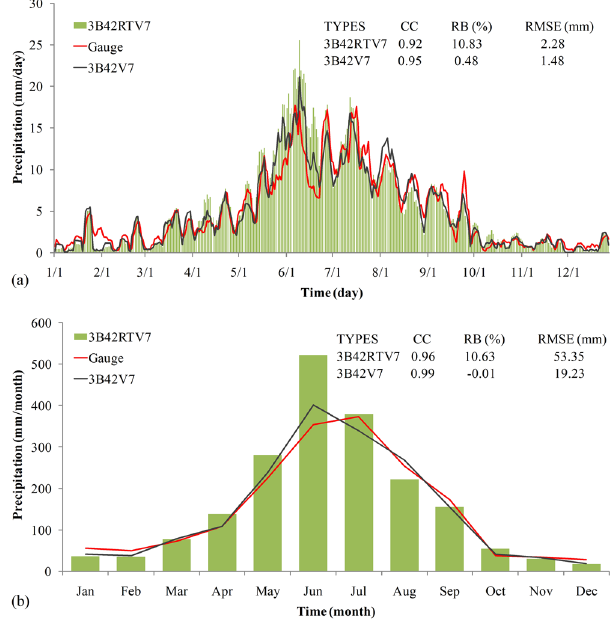
Figure 7. Selected grid-based mean daily ( a ) and monthly ( b ) precipitation over a year. A five-day moving average was used for daily precipitation for both gauge observations and TMPA products to enhance the trend